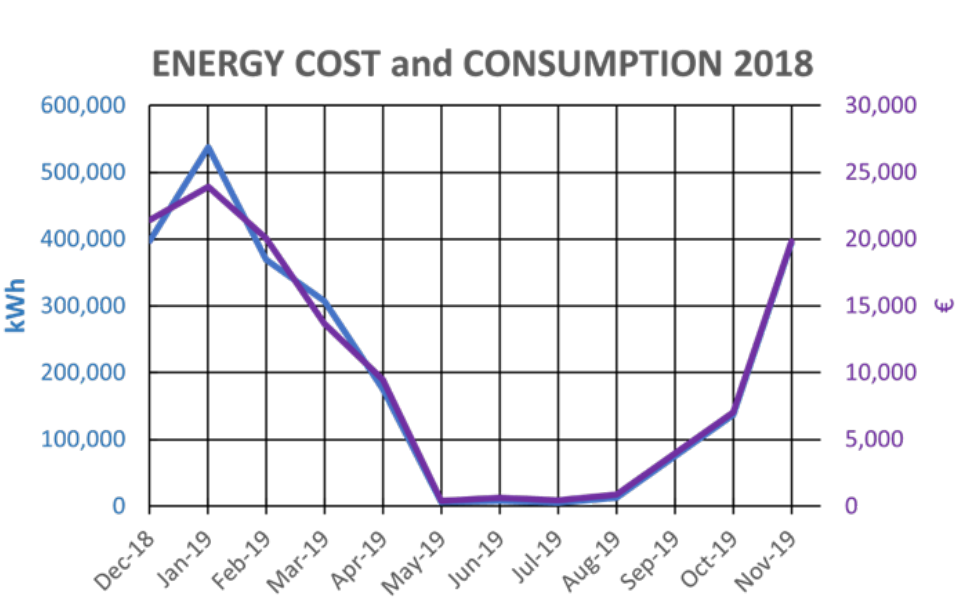
Table 4. Global Infrastructure